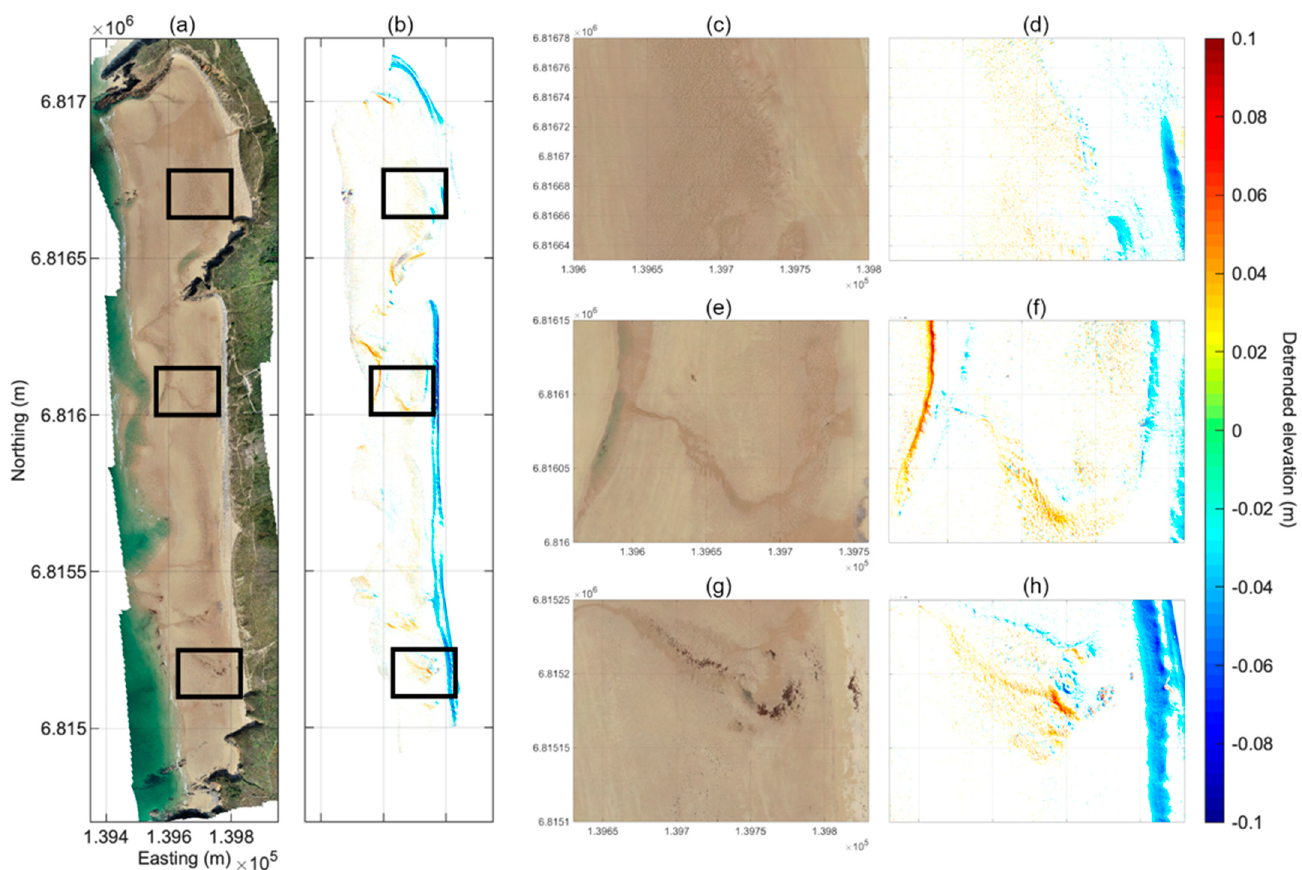
Figure 8. Application of RTK quadcopter and SfM photogrammetry for very-high-resolution measurement of topographic roughness and bedform mapping at the beach-scale at La Palue field site. ( a ) Orthophoto and the different zones investigated in panels ( c – h ); ( b ) 0.1 m resolution DEM detrended from metric topography (cf. explanation in the text); ( c – h ) 0.1 m resolution orthophotos and detrended DEMs cropped to the areas of interest. Detrended elevations below 0.02 m are not shown to help with figure comprehension. The colorbar is same for all DEMs.